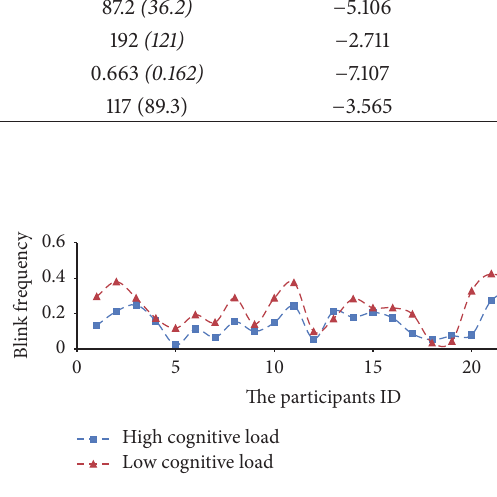
Figure 4: The blink frequency of 24